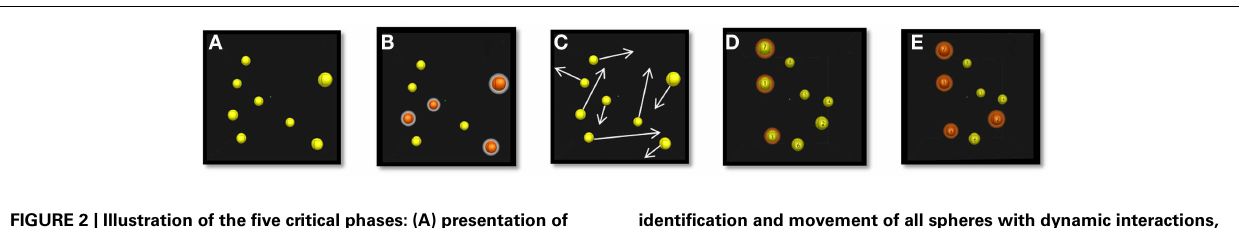
FIGURE 2 | Illustration of the five critical phases: (A) presentation of randomly positioned spheres in a virtual volumetric space, (B) identification of the spheres to track during trial, (C) removal of